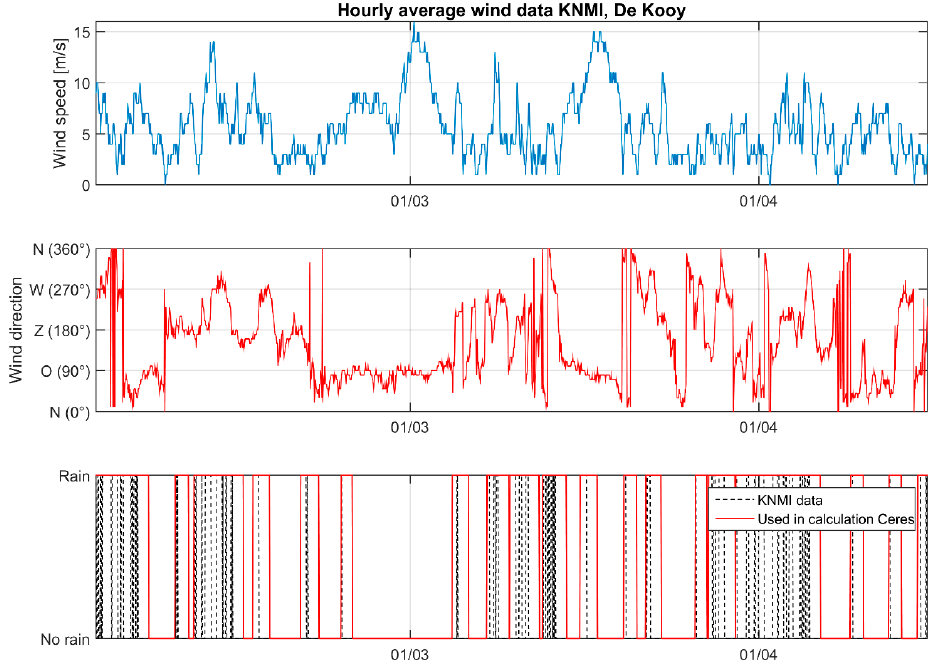
Figure 13. Wind speed, direction and precipitation at weather station De Kooy, Netherlands.